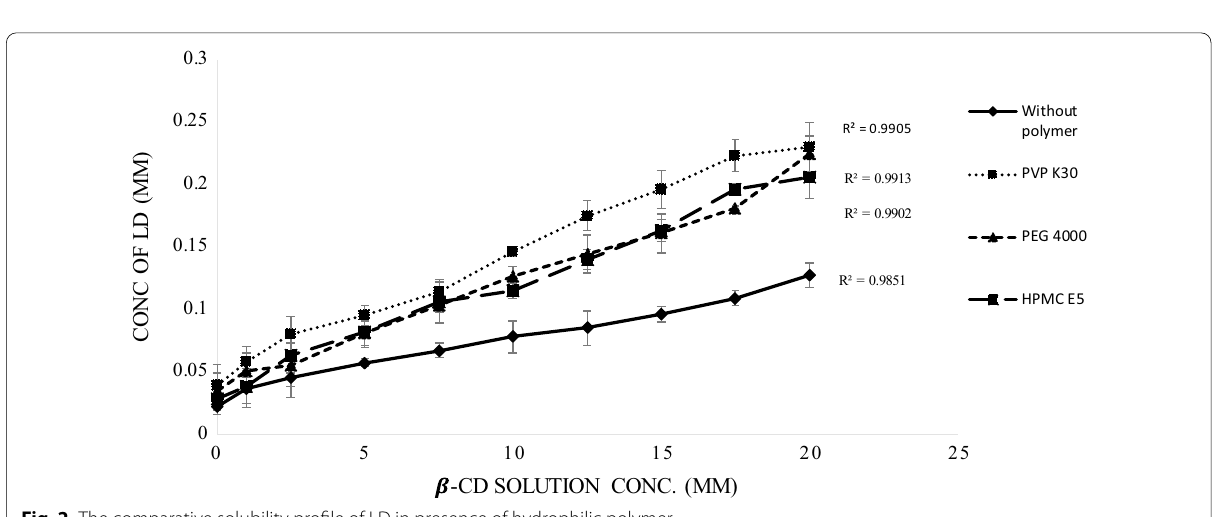
Fig. 2 The comparative solubility profile of LD in presence of hydrophilic polymer